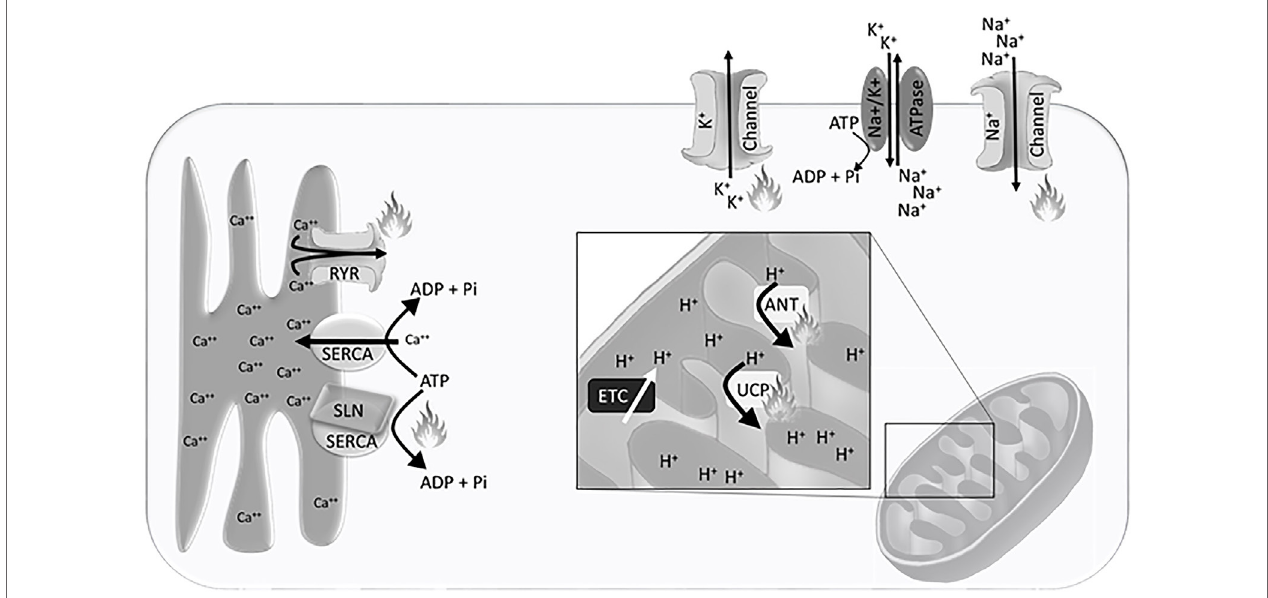
FiGURe 1 | Schematic representation of the Ca ++ gradient at the sarcoplasmic reticulum, H + gradient at the inner mitochondrial membrane, and Na + /K + gradient at the plasma membrane. Flames indicate sites of heat generation from ion leak and non-functional adenosine triphosphate (ATP) hydrolysis. Abbreviations: SERCA, sarco/endoplasmic reticulum Ca ++ ATPase; RYR, ryanodine receptor; SLN, sarcolipin; ETC, electron transport chain; UCP, uncoupling protein; ANT, adenine nucleotide translocase.